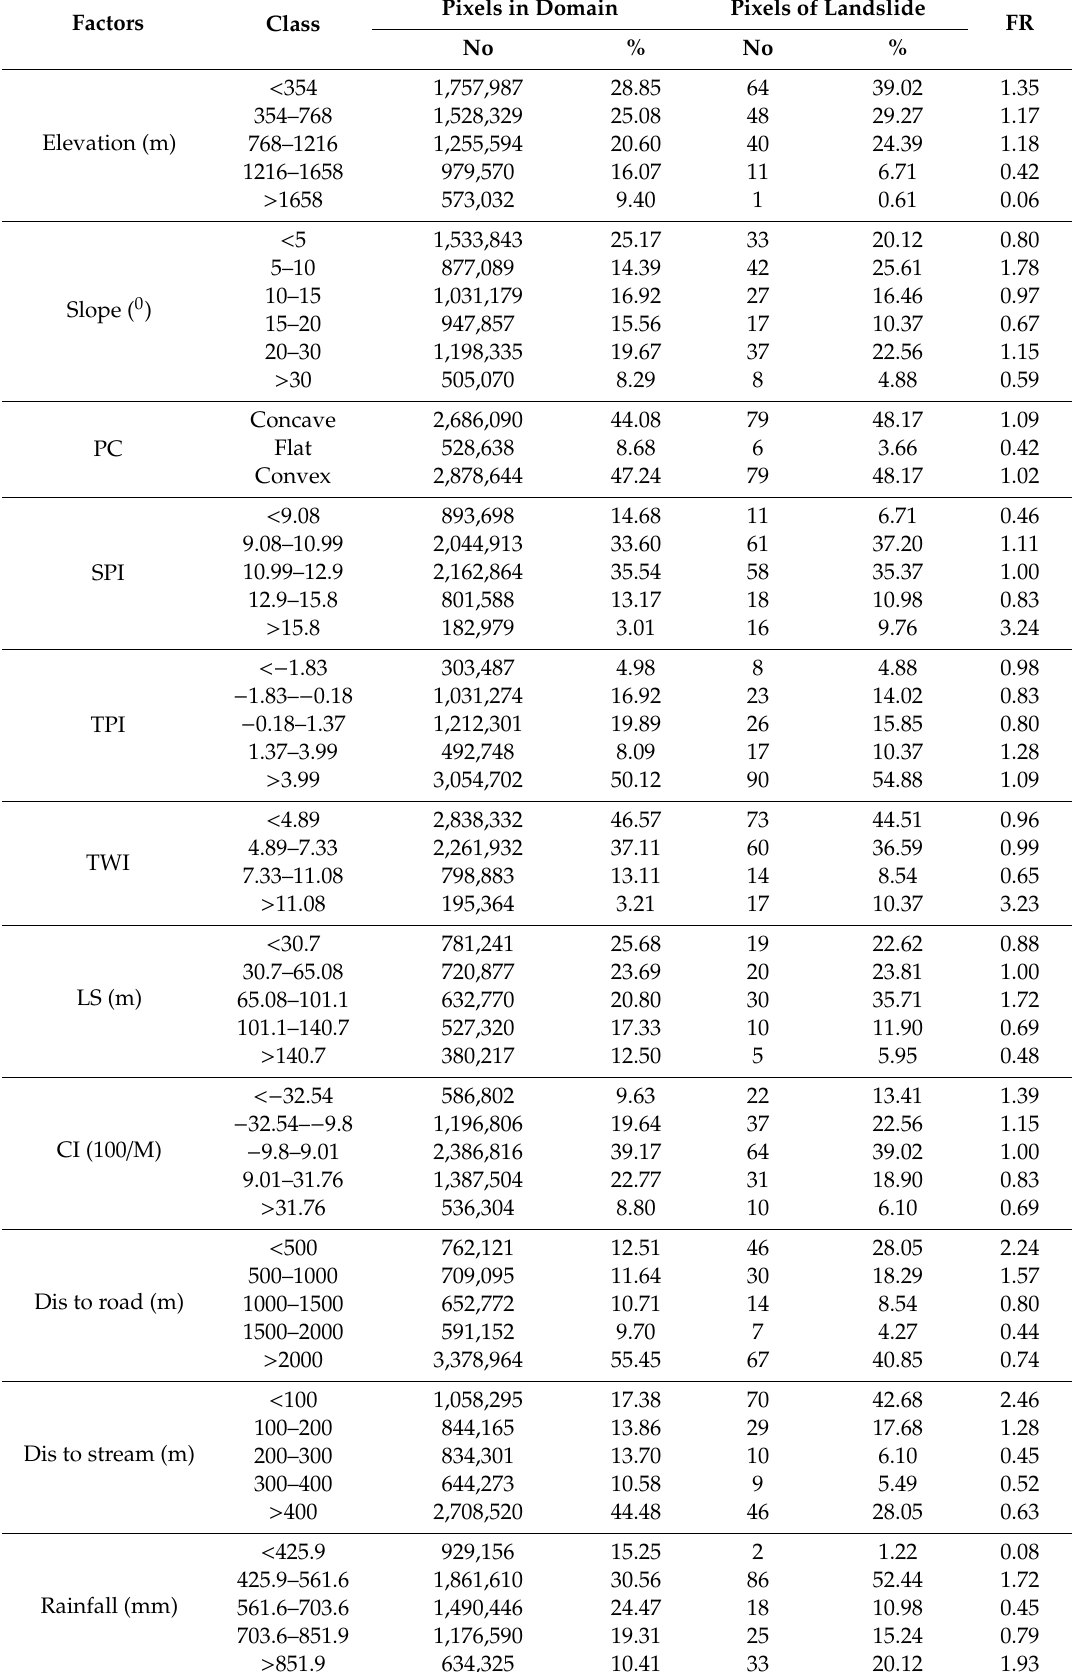
Table 3. The spatial relationship between LCFs and landslides by FR